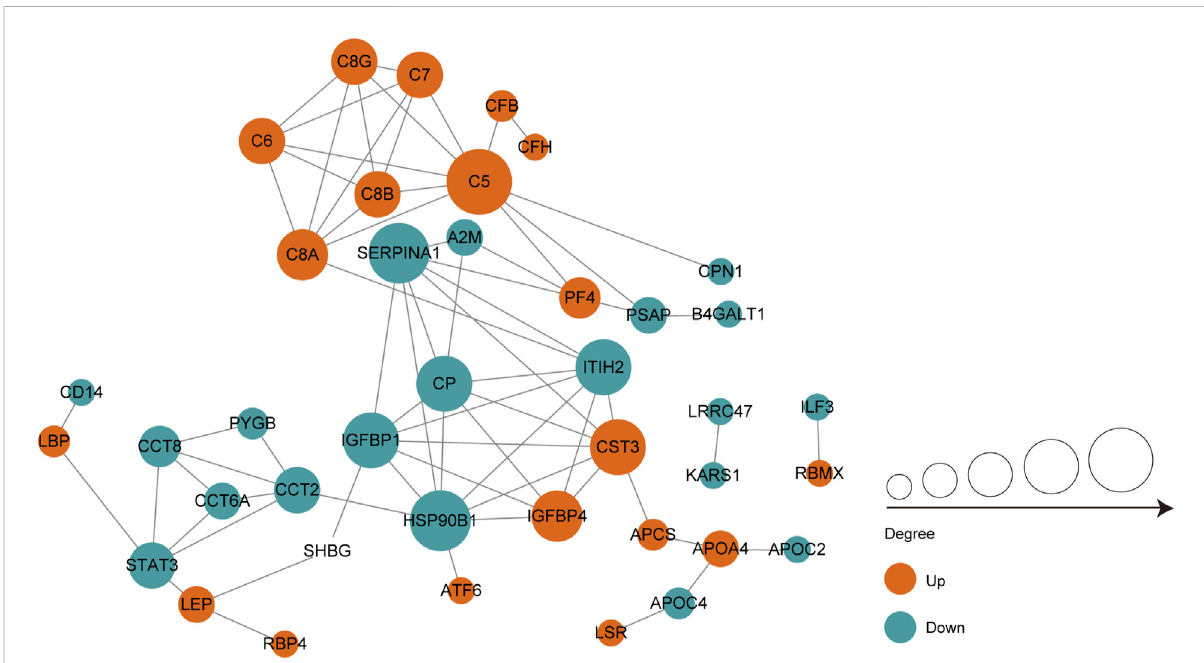
FIGURE 4 PPIco-expressionnetworkofdifferentiallyexpressedproteins(DEPs)infollicular fl uidofPCOSwomenandcontrols. Fortyofthe70DEPswere predictedtoparticipateindirectPPIs.NodesrepresentproteinsandlinesrepresentPPIs.Thedegreedeterminesthenodesize,whereredrepresents upregulated and the green represents downregulated.